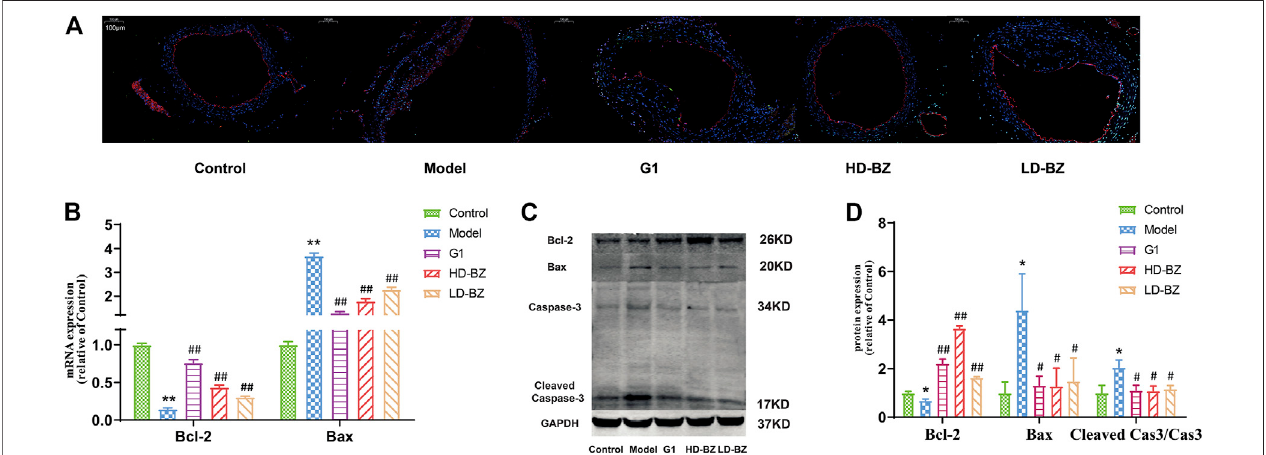
FIGURE 3 | Effect of BZBS on endothelial cell apoptosis in Ovx/ApoE -/- mice. (A) Images from the TUNEL apoptosis assay were used to quantify apoptotic ECs in aortic arch atherosclerotic plaques in mice. (B) Bcl2 and Bax mRNA levels were determined by quantitative real-time PCR analysis. GAPDH was used as an internal reference gene. (C) Western blots showing Bcl2, Bax, and caspase-3 analytes. (D) Graph showing the values derived from the quanti fi cation of the bands shown in C; GAPDH was used as an internal reference protein. The data are presented as the mean ± SD. * p < 0.05, ** p < 0.01 vs. the control group; # p < 0.05, ## p < 0.01 vs. the model group ( n (cid:1) 4 –